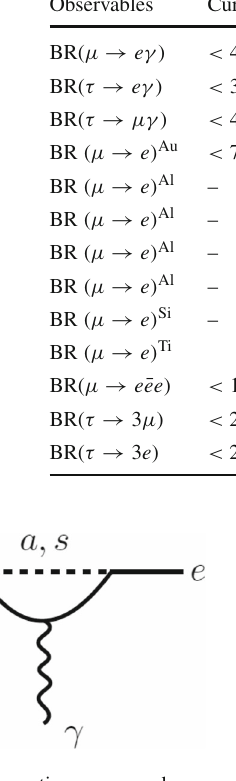
Fig. 10 Feynman diagram representing μ → e γ decay